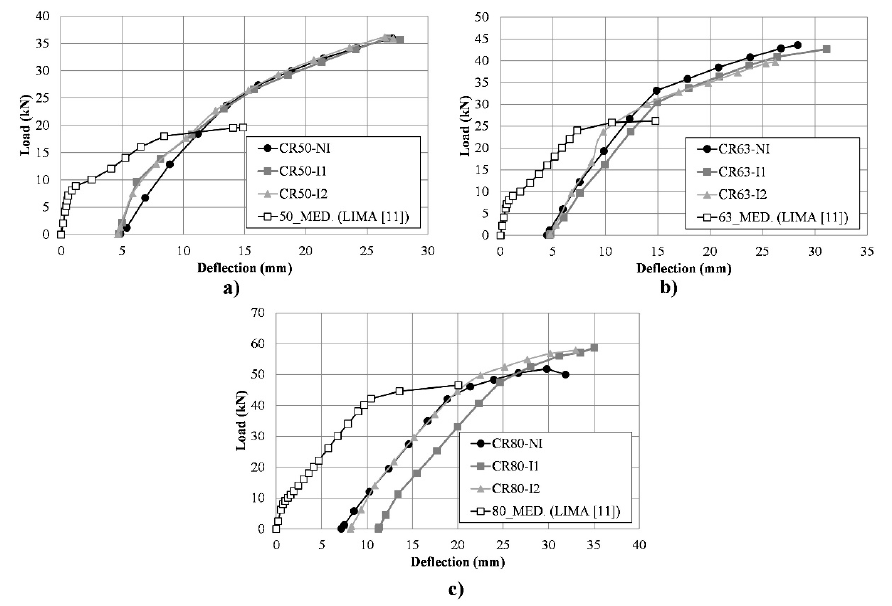
Figure 14. Load-deflection curves comparing rehabilitated beams with the original undamaged beams tested by Lima [12]: a) CR50; b) CR63; c) CR80. Load (kN) represents the sum of the loads (2P) applied to the beam.